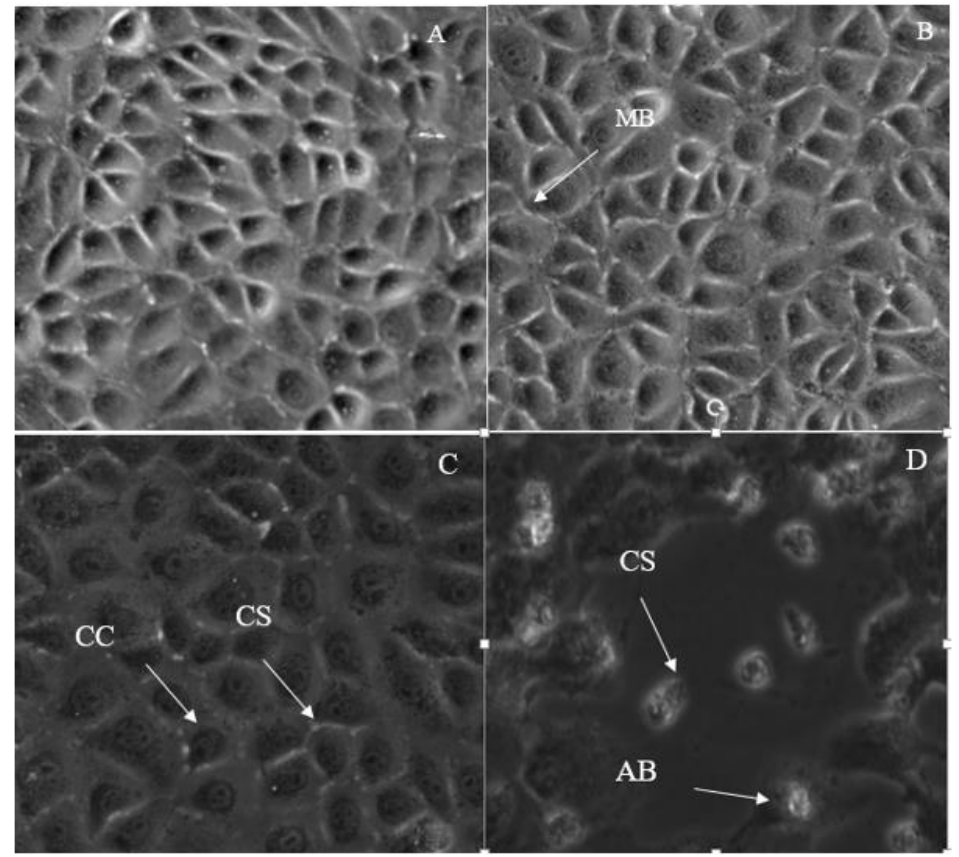
Figure 10. Morphological changes in MCF-7 treated with 7-geranyloxycinnamic acid using phase contrast microscope (200 × magnification); ( A ) untreated, ( B ) 24 h, ( C ) 48 h and ( D ) 72 h of incubation. Cell population decreased with the incubation time. MCF-7 cells showed the features of apoptosis such as membrane blebbing (MB), chromatin condensation (CC), cellular shrinkage and rounding (CS) and formation of apoptotic bodies (AB).